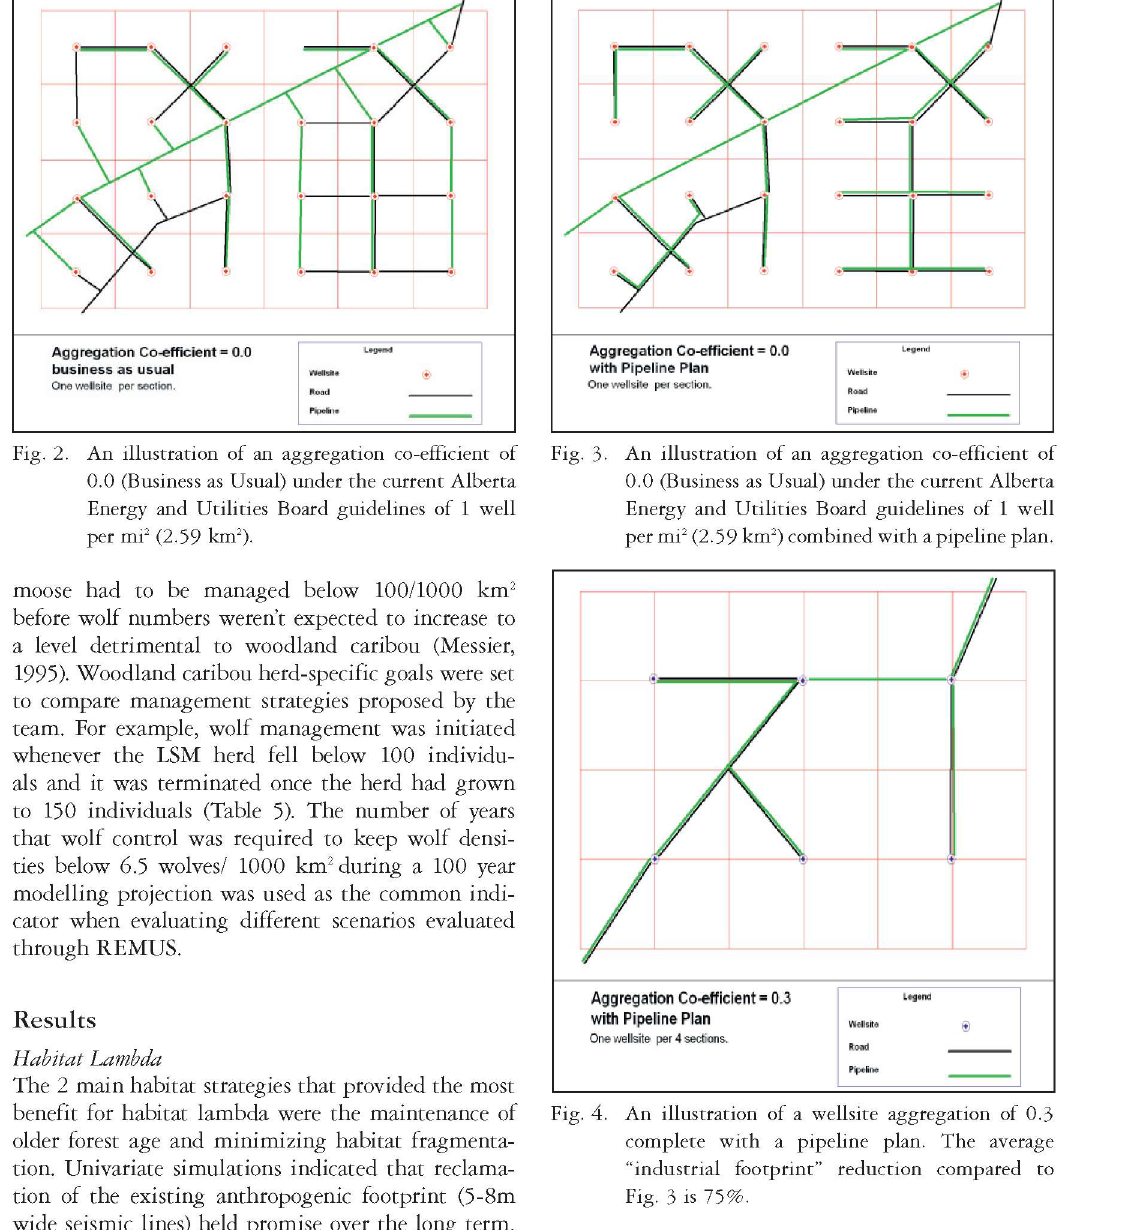
Fig. 3. An illustration of an aggregation co-efficient of 0.0 (Business as Usual) under the current Alberta Energy and Utilities Board guidelines of 1 well per mi 2 (2.59 km 2 ) combined with a pipeline plan.